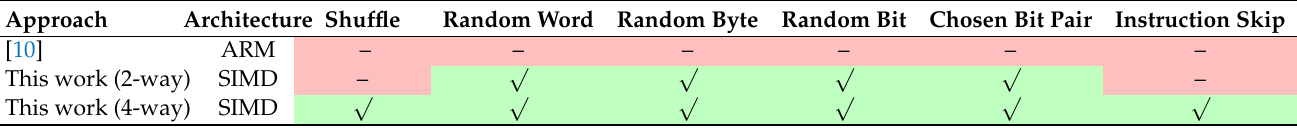
Table 4. Comparison of fault detection capability depending on the implementation of HIGHT algorithm on target embedded processors. Red color and green color represent disadvantage and advantage of approaches,